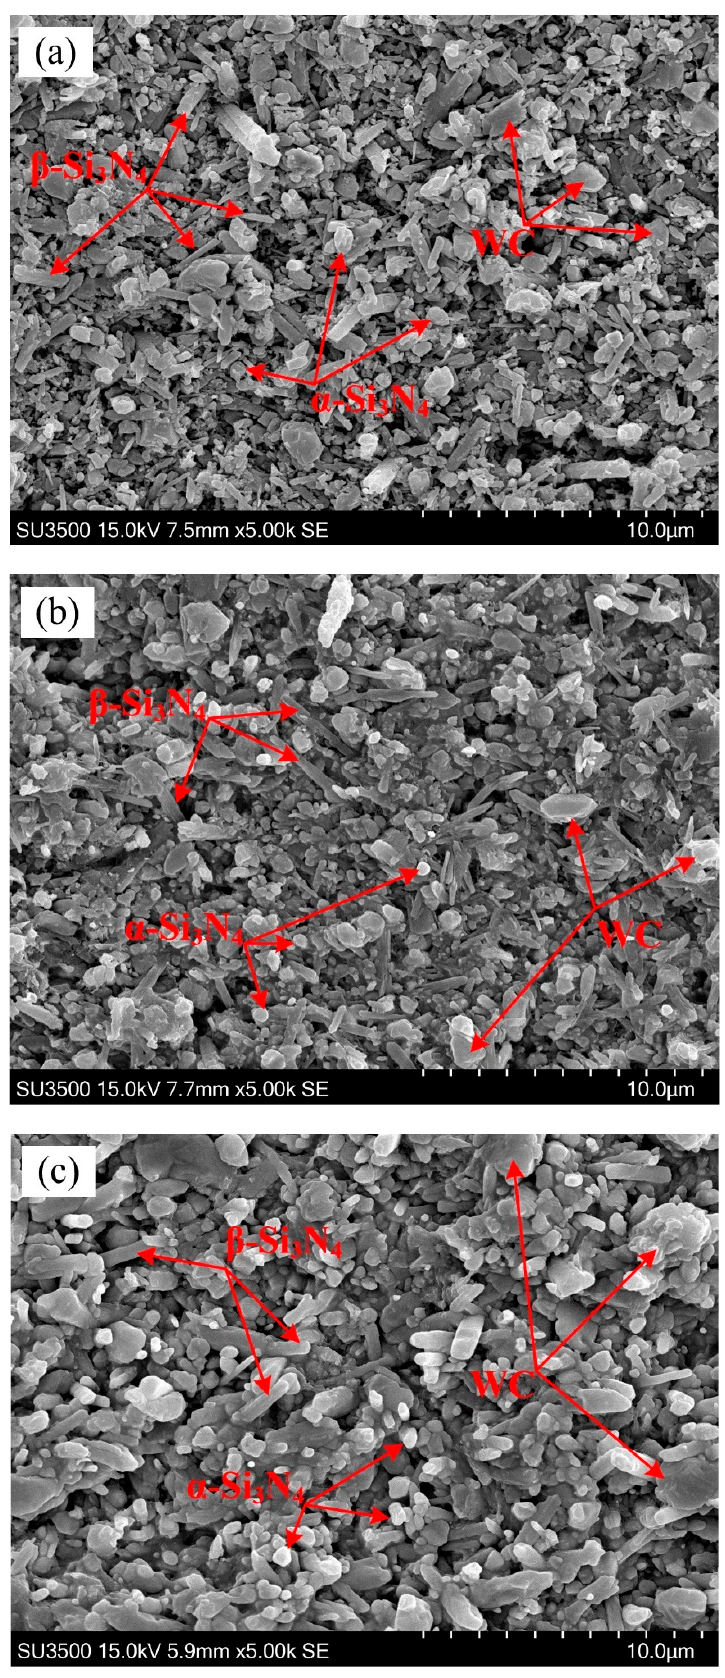
Figure 6. SEM micrograph of the Si 3 N 4 -based ceramic with 10 wt % WC after being corroded. ( a ) 1 wt % Co, ( b ) 2 wt % Co, and ( c ) 4 wt % Co.